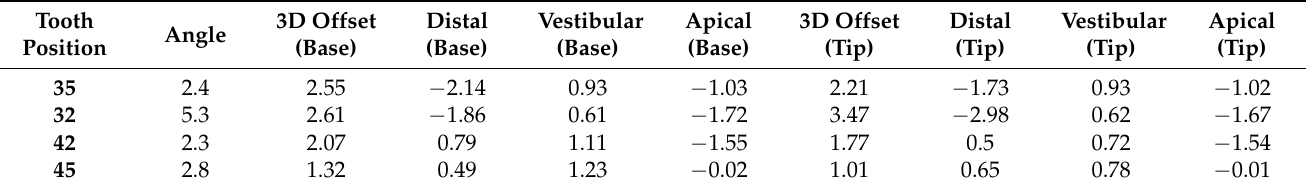
Table 1. Accuracy analysis with postoperative